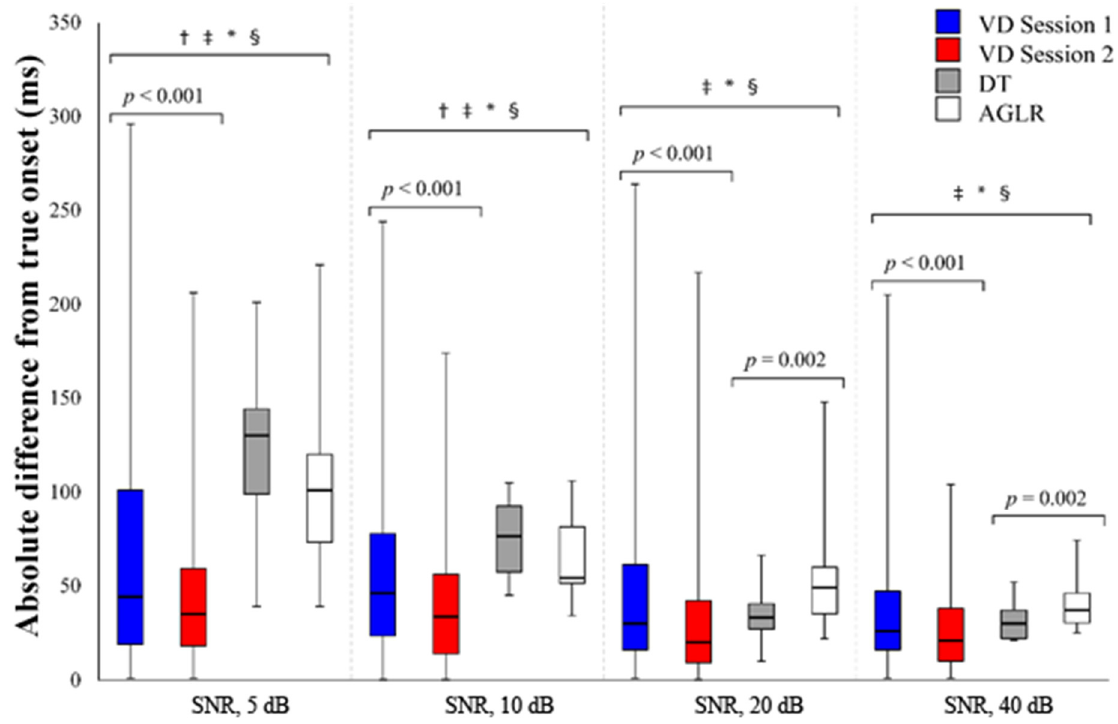
Figure 3. Absolute difference from the true onset (ms) for the different onset detection methods with signal-to-noise ratios of 5, 10, 20, and 40 dB. VD = visual detection; DT = double threshold; AGLR = approximated general likelihood ratio; † represents a significant ( p < 0.05) difference between VD session 1 and the DT; ‡ represents a significant ( p < 0.05) difference between VD session 1 and the AGLR; * represents a significant ( p < 0.05) difference between VD session 2 and the DT; § represents a significant ( p < 0.05) difference between VD session 2 and the AGLR.